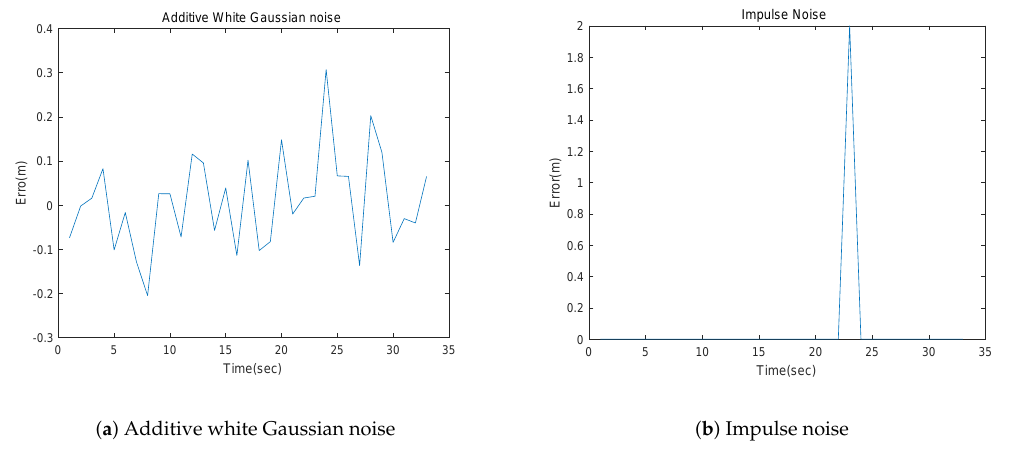
Figure 2. Additive white Gaussian noise and impulse noise.